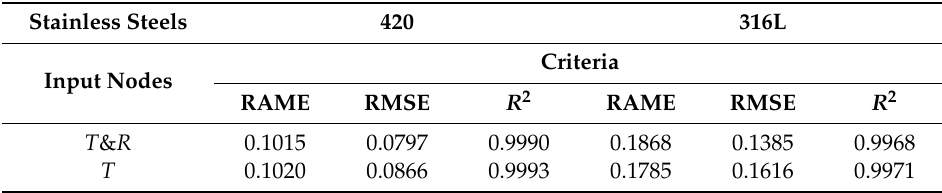
Figure 5. Relative absolute mean error (RAME), root mean square error (RMSE), and R 2 for models with different numbers and types of input nodes and different stainless steels ( a ) 420 and ( b ) 316L. Table 3. RAME, RMSE, and R 2 for the models with input nodes of T & R and the models with input node of T in Figure 3.